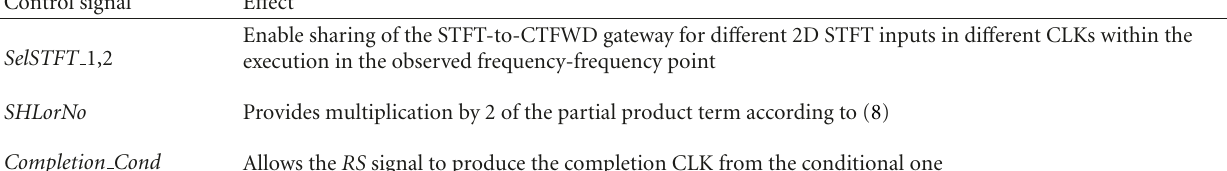
Table 4: Function of control signals generated by the Main Ctrl and the ctrl of windowed convolution and padding borders. Control